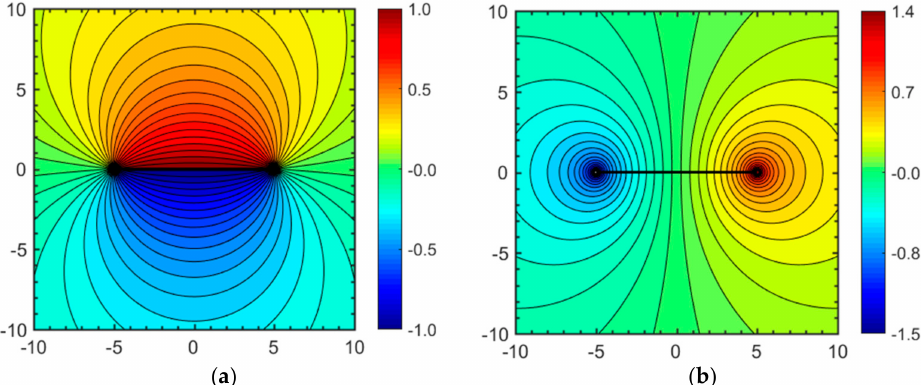
Figure 10. Line doublet with ( a ) Potential function values ( Φ ) given by rainbow colors (m 2 · s − 1 ) relative to line y = 0. ( b ) Stream function values ( Ψ ) given by rainbow colors (m 2 · s − 1 ) relative to line y = 0. Strength of line doublet ( m ) = 20 m 3 · s − 1 and z a = − 5 and z b = 5.